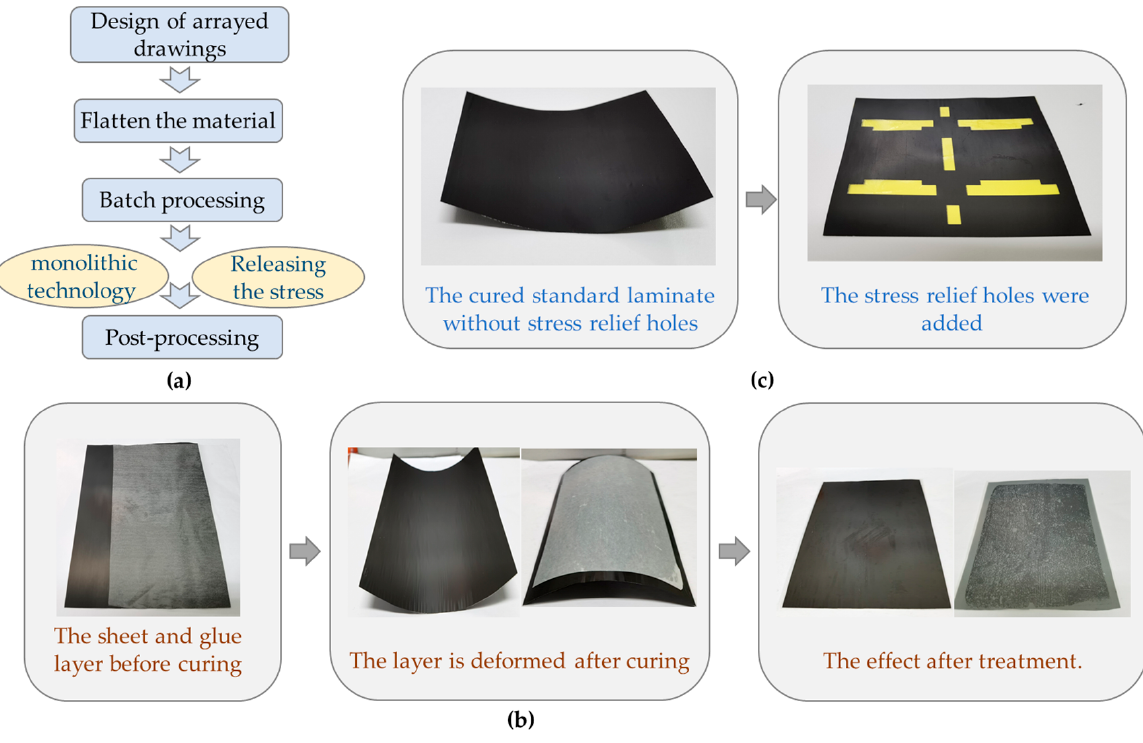
Figure 9. Batch processing method based on monolithic technique: ( a ) the whole idea of batch processing; ( b ) treatment of deformation of material layer; ( c ) standard laminate layer with stress relief holes.